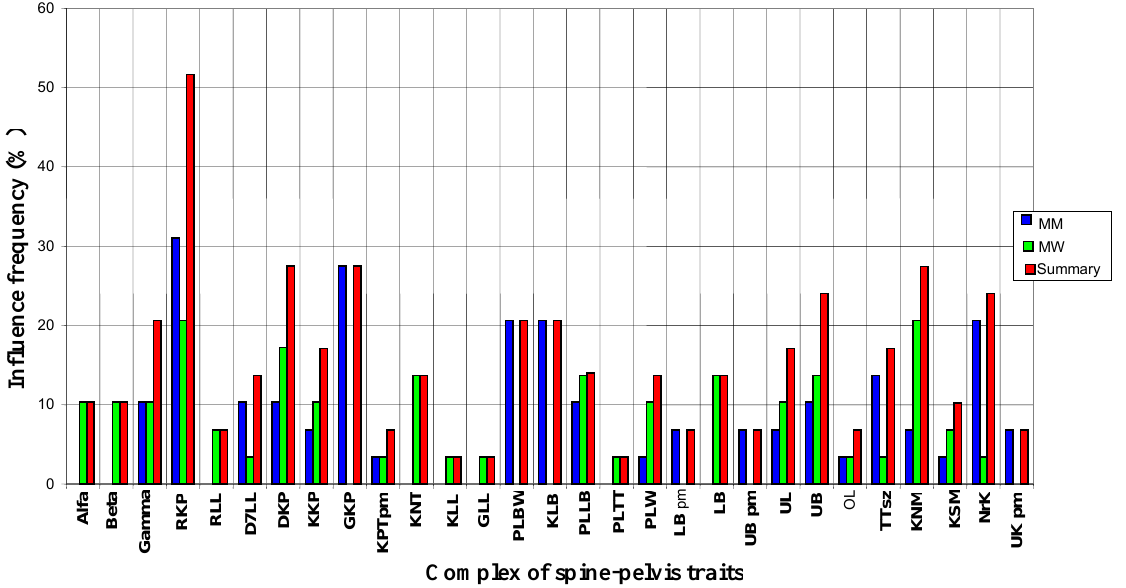
Fig. 1 Percentage of significant correlations among the complex of the spine-pelvis traits and the feet traits in the population of boys aged 4 to 6 years from rural areas and cities (n) MM=727, MW=779 The correlations between the feet traits and the complex of the pelvis-spine traits Boys living in